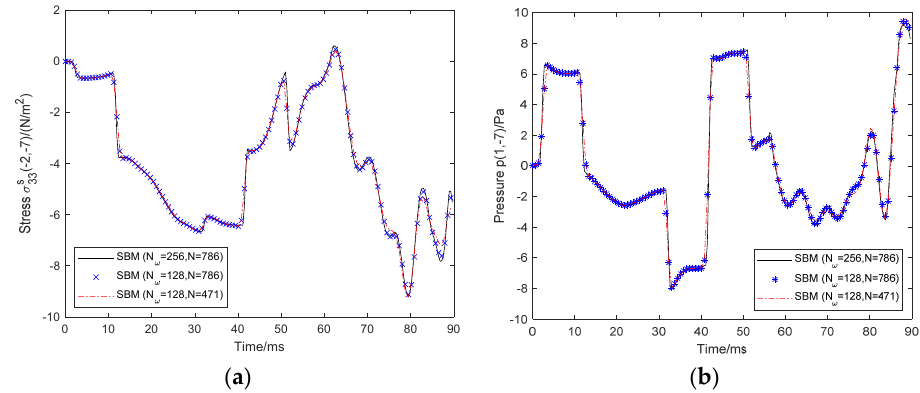
s σ at ( − 2, − 7) and ( b ) p at (1, − 7) under different sampling numbers at ( − 2, − 7) and ( b ) p at (1, − 7) under different sampling numbers 33